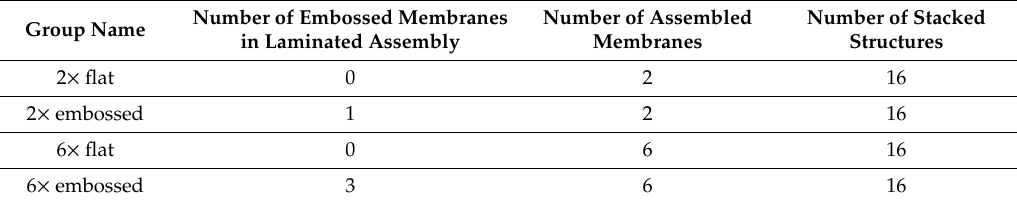
Table 1. Experimental